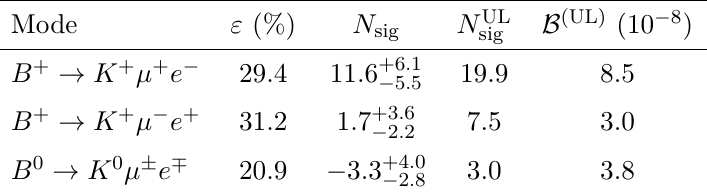
Table 3 . Branching fraction UL calculation at 90% CL for LFV B → Kµe